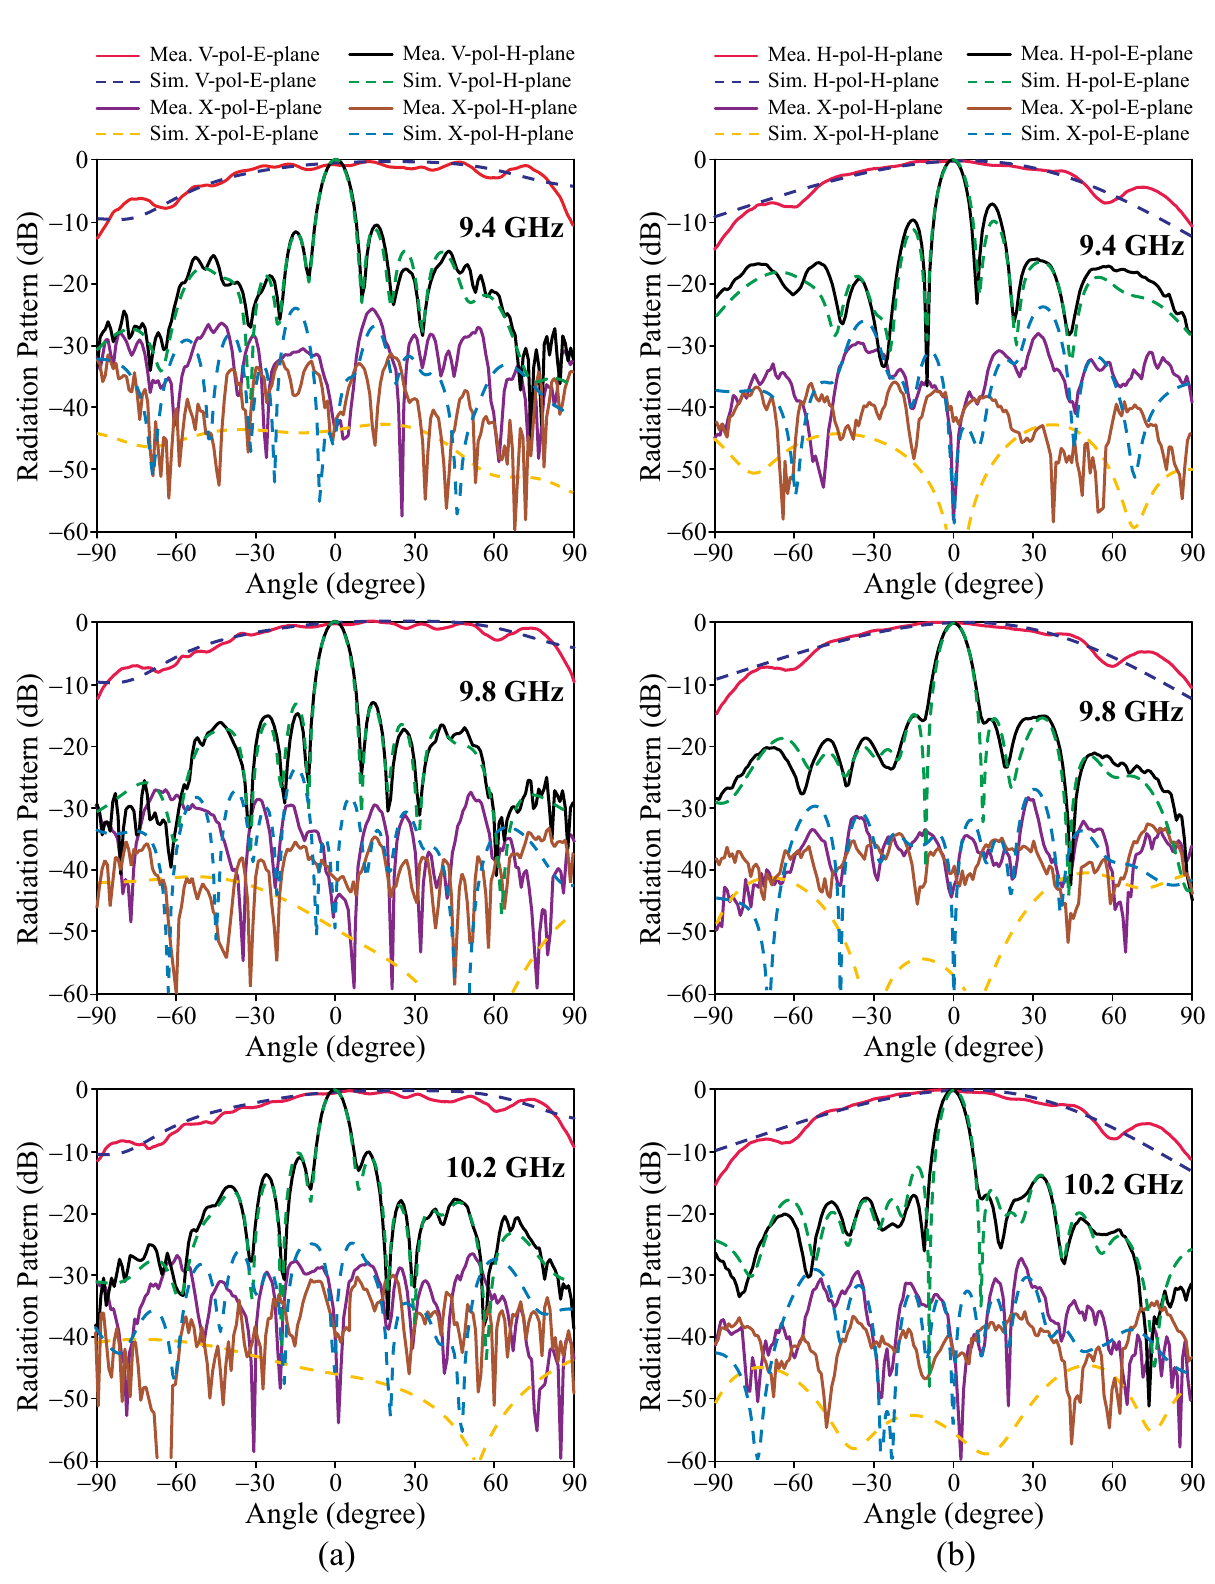
Figure 14. Simulated and measured normalized radiation patterns of the antenna in the E plane and H plane at three operating frequencies of 9.4, 9.8, and 10.2 GHz of: ( a ) VP linear array radiation pattern. ( b ) HP linear array radiation